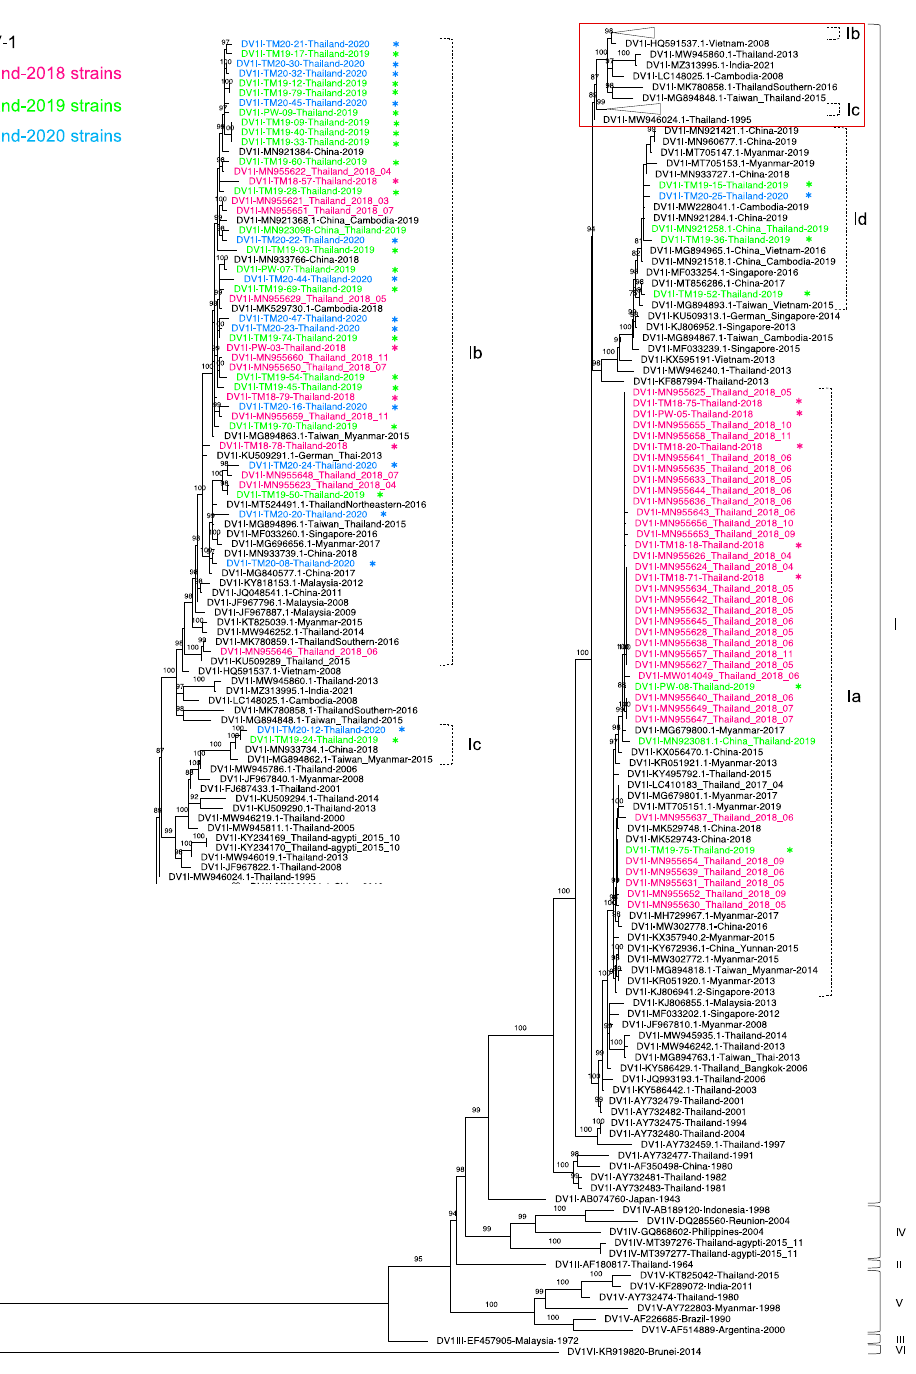
Figure 1. Phylogenetic analysis of Thailand DENV-1 in 2015–2020. The maximum-likelihood (ML) tree was constructed based on the complete envelope (E) region sequences (1485 nucleotides) under TIM2 + F + I + G4 with 1000 ultrafast bootstrap replicates. The ML tree included 46 newly determined sequences of DENV-1 from clinical specimens from Bangkok in 2018–2020, their related strains, Thailand strains during 2015–2020, and the reference genotypes. The sequences collected in 2018, 2019, and 2020 are labeled in pink, green, and blue, respectively, and indicated in the upper left corner. The sequences newly determined in the present study are marked with asterisks (*). Viral genotypes and clades are indicated by black and dotted brackets, respectively, on the right. Sequences are shown by serotype, accession number, country, and reported year. Numbers on branches are bootstrap support values exceeding 80%. Details of the collapsed portion of the tree in the red square in the upper right including clades b and c are shown in the middle.